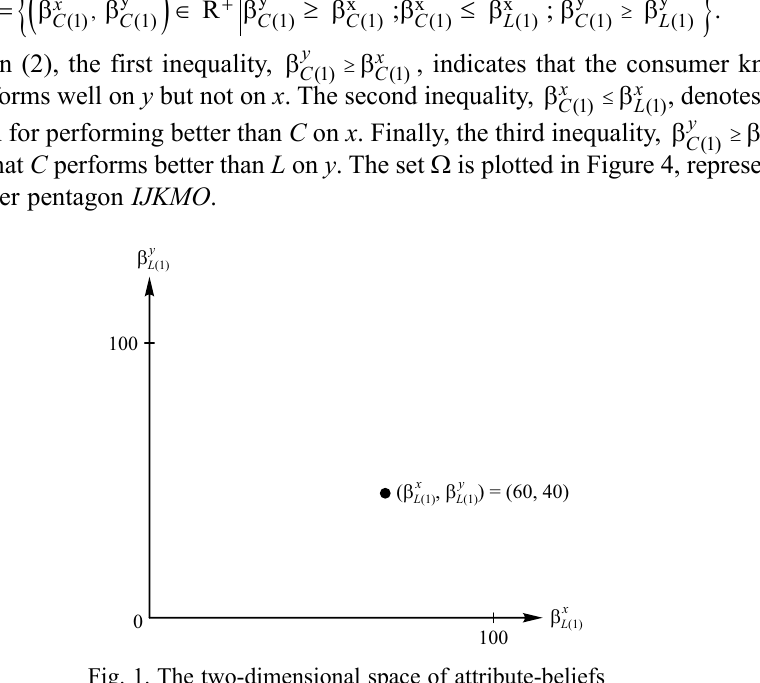
Fig. 1. The two-dimensional space of